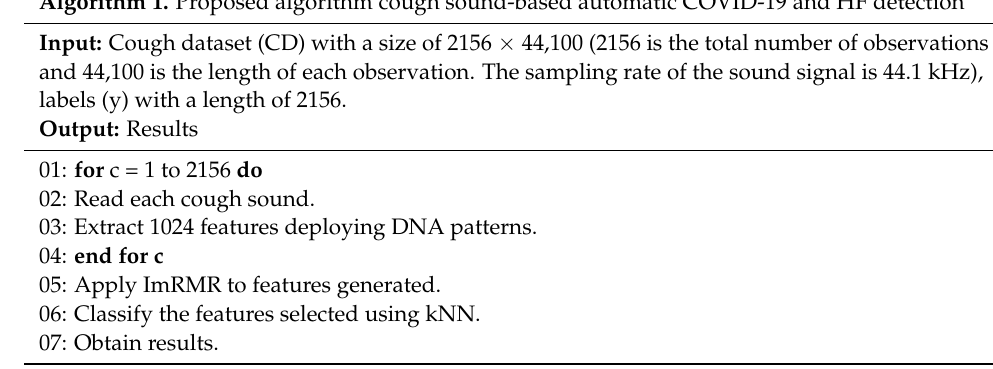
Algorithm 1. Proposed algorithm cough sound-based automatic Covid-19 and HF detection